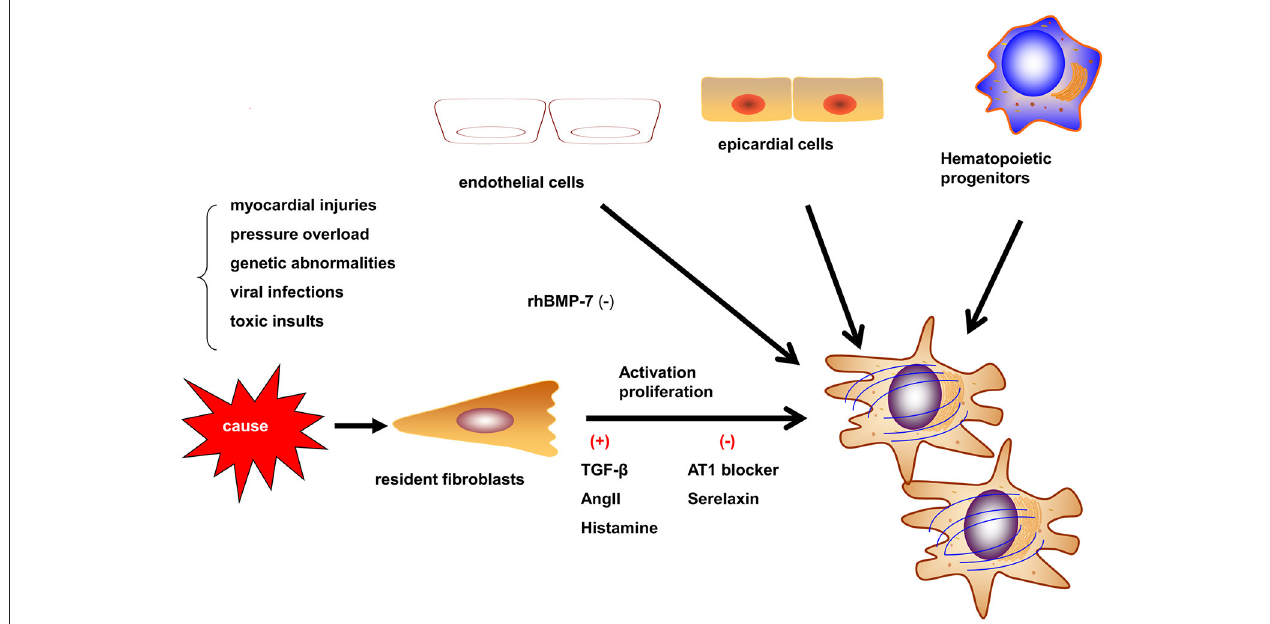
FIGURE 1 | Origins and activation of myofibroblasts. Myofibroblasts can be activated in different situations such as myocardial injury, pressure overload, and genetic abnormalities. Myofibroblasts may be derived from resident fibroblasts, bone marrow-derived fibroblasts, epithelial-to-mesenchymal transition, and endothelial-to-mesenchymal transition (EndMT). The contribution of different origins may be variable in different